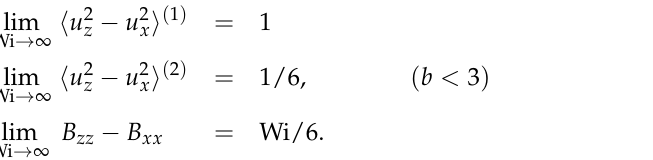
. ( a ) ε 0 = 0, ( b ) ε 0 = 0